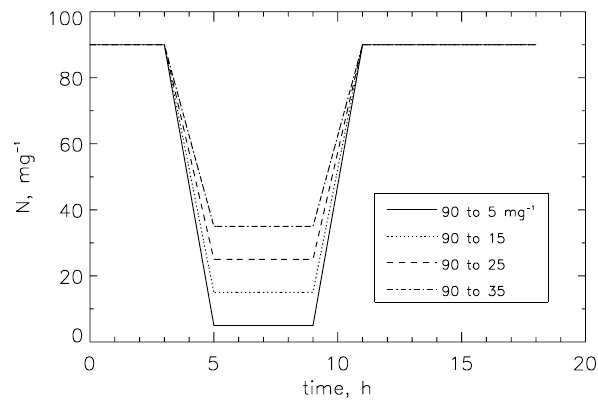
Figure 1. Imposed time series of drop concentration N . The mini- mum N is varied between 5 and 35mg − 1